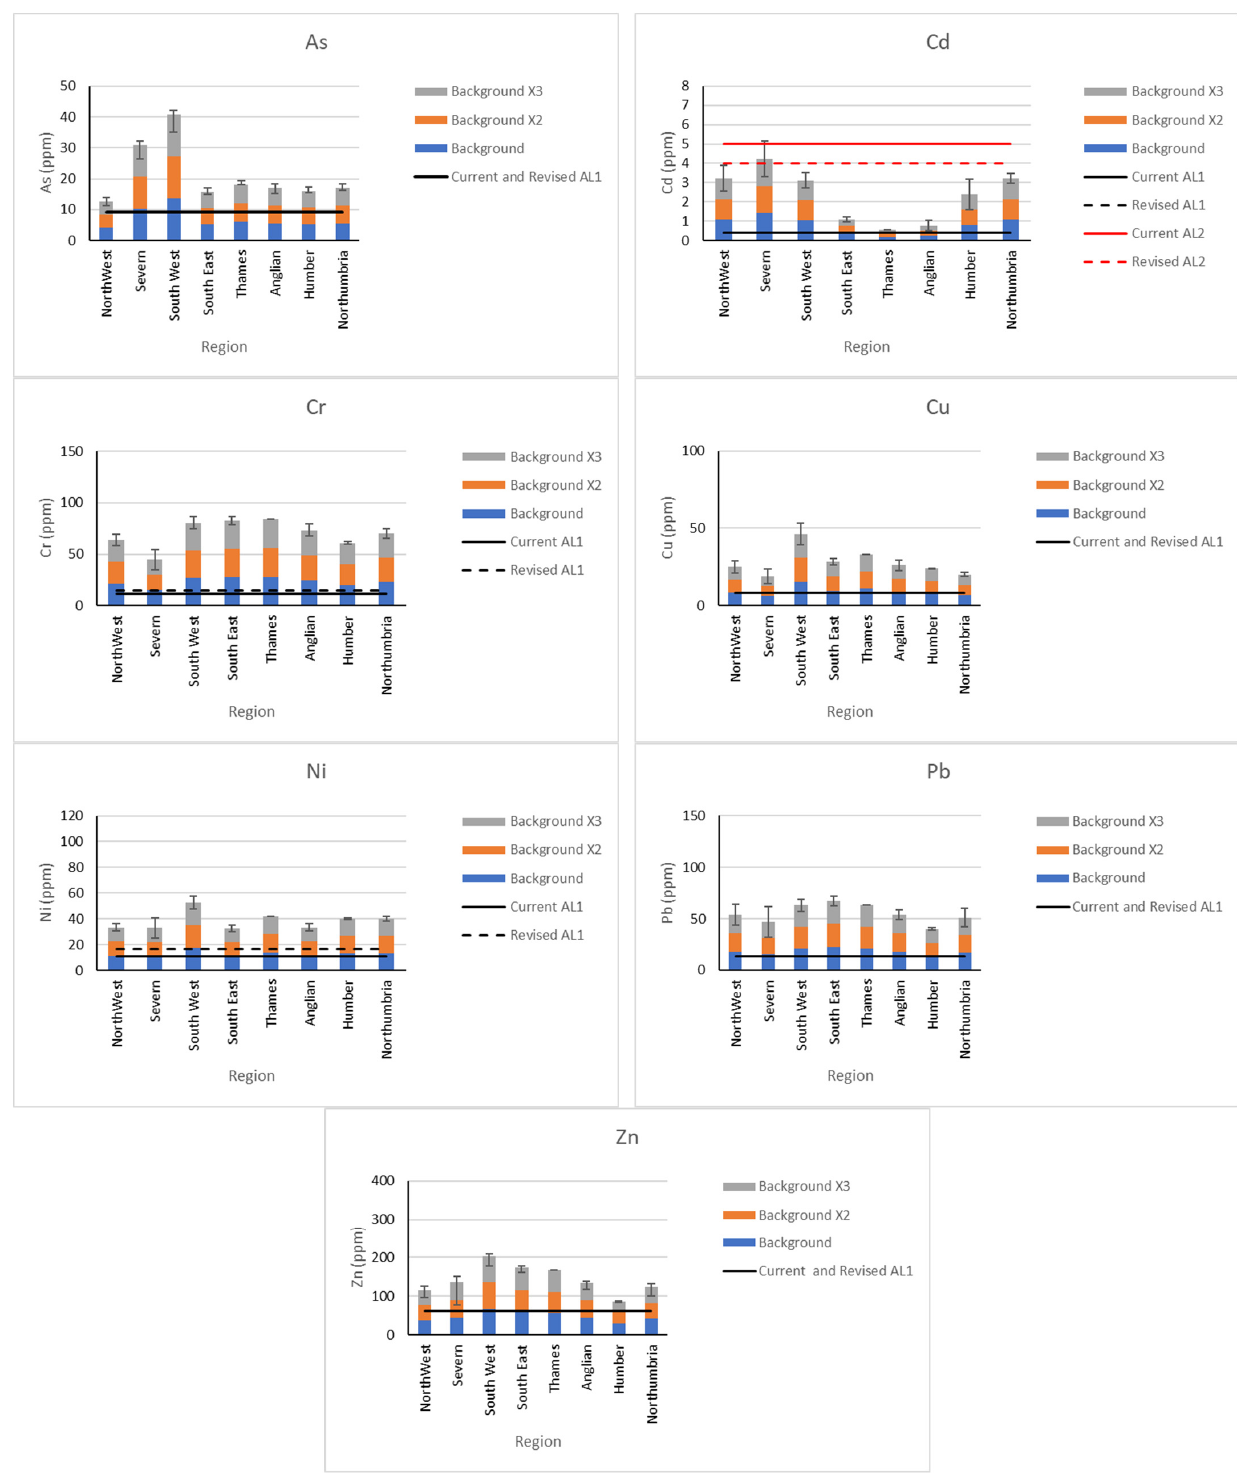
Figure 6. Trace metals—background, background X2, background X3 for each region with the current and revised AL1s (if different) indicated (current and revised AL2 shown only for cadmium (Cd). Note that if the current AL1 and revised AL1 are the same, only the AL1 shown. Error bars (95% confidence limits calculated by standard deviation X number of samples X 0.05) are indicated as a line on each stacked bar and apply to the whole bar. No regional background concentrations were developed for mercury (Hg). Regions are in geographic order starting from the Northwest coast ending in Northumbria (Figure 5). Figure adapted from